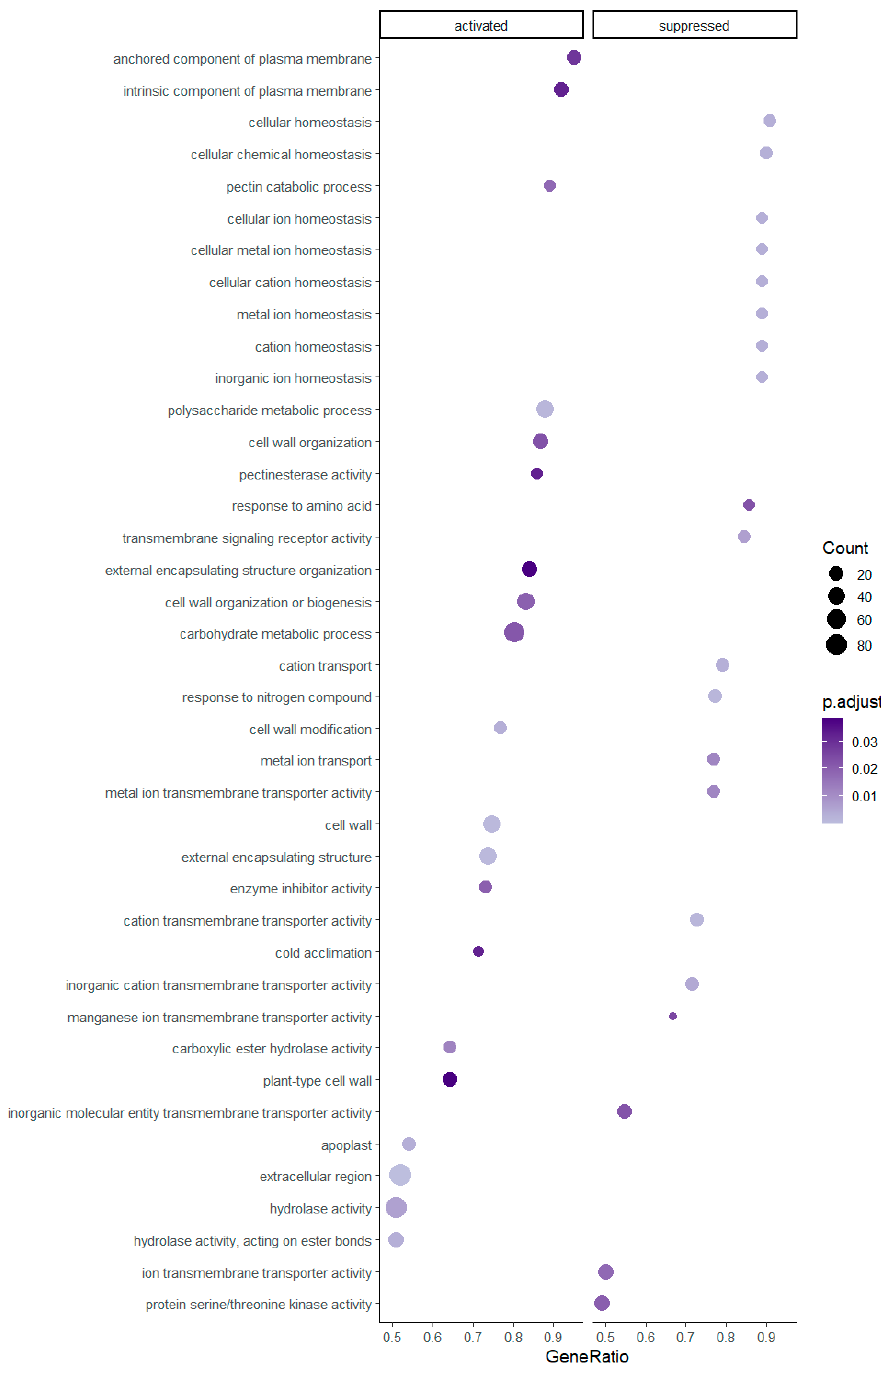
Figure 2. Significantly enriched gene set pathways resulting from the analysis of differentially expressed genes in diploid individuals of R. kuepferi .